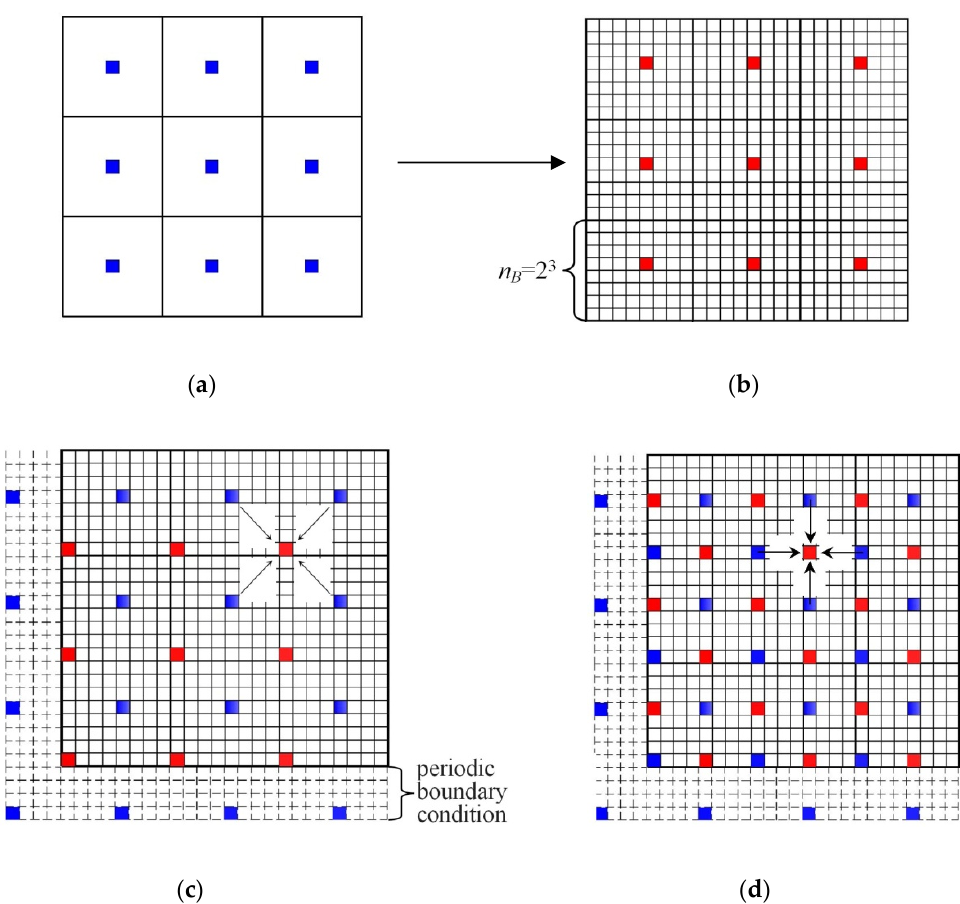
Figure 1. Diagram of temperature interpolation on a fragment of the main grid with blocks of size 2 3 × 2 3 for two consecutive steps of calculations. ( a ) calculation of temperature field on coarse lattice; ( b ) Transfer of temperatures from a coarse lattice to central cells of CA blocks; ( c ) step 1. calculation of average temperature on the basis of neighborhood √ √ ( ± 2 n − 1 a 2, ± 2 n − 1 a 2 ) ; ( d ) step 2. calculation of average temperature on the basis of neighborhood ( ± 2 n − 1 a , ± 2 n − 1 a )